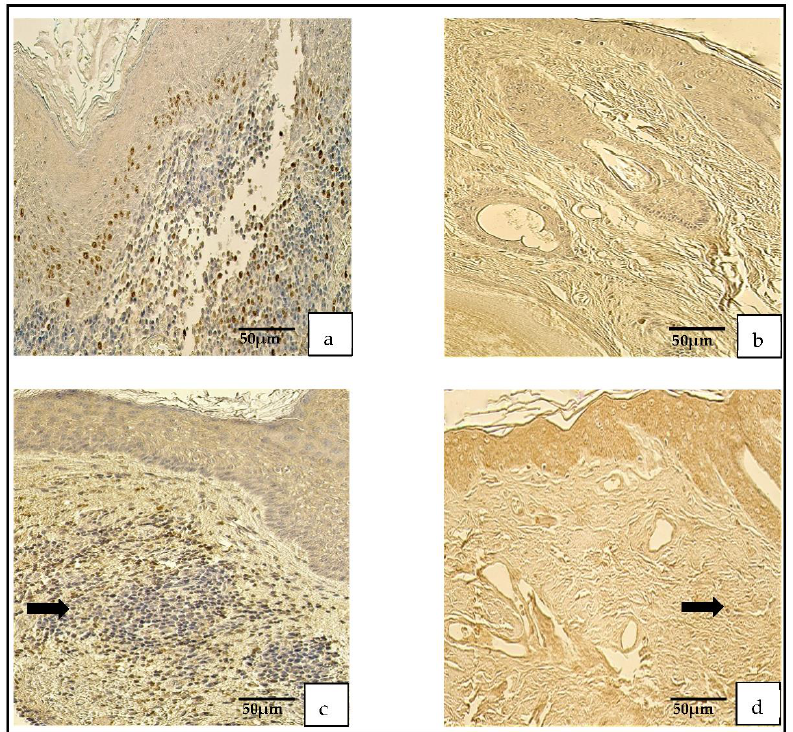
Figure 2. Immunohistochemical micrographs. ( a ) Cholesteatoma . A few Ki-67-positive cells in the matrix and the perimatrix, Ki-67 IHC. ( b ) Skin. Absence of Ki-67-positive cells in the epithelium and the connective tissue (arrows), Ki-67 IHC. ( c ) Cholesteatoma . Moderate-to-numerous NF- κβ - positive cells in the matrix and a few in the perimatrix (arrow), NF- κβ IHC . ( d ) Skin. Moderate NF- κβ - positive cells in the epithelium and a few (arrow) in the connective tissue, NF- κβ IHC.